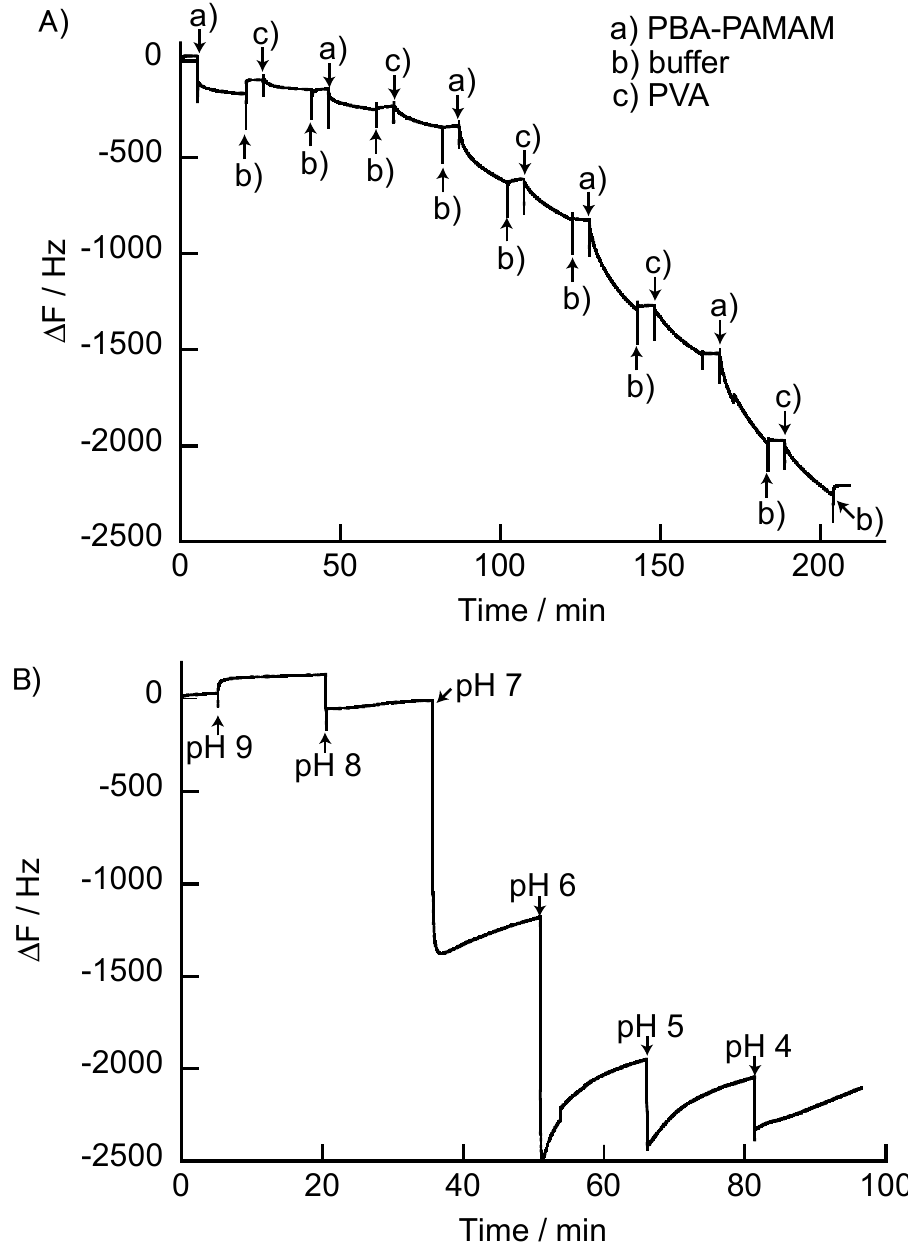
Figure 7. ( A ) frequency change ( Δ F) in quartz crystal microbalance (QCM) for the preparation of the (PBA-PAMAM/PVA) n film, and ( B ) frequency changes when the (PBA-PAMAM/PVA) 5 film is immersed in different pH buffers. The resonator was exposed to (a) 0.1 mg/mL PBA-PAMAM, (b) buffer (pH 9), and (c) 0.1 mg/mL PVA.